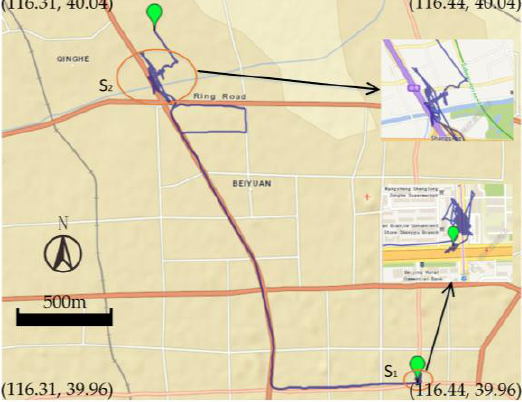
Figure 6. An example of a labeled trajectory.